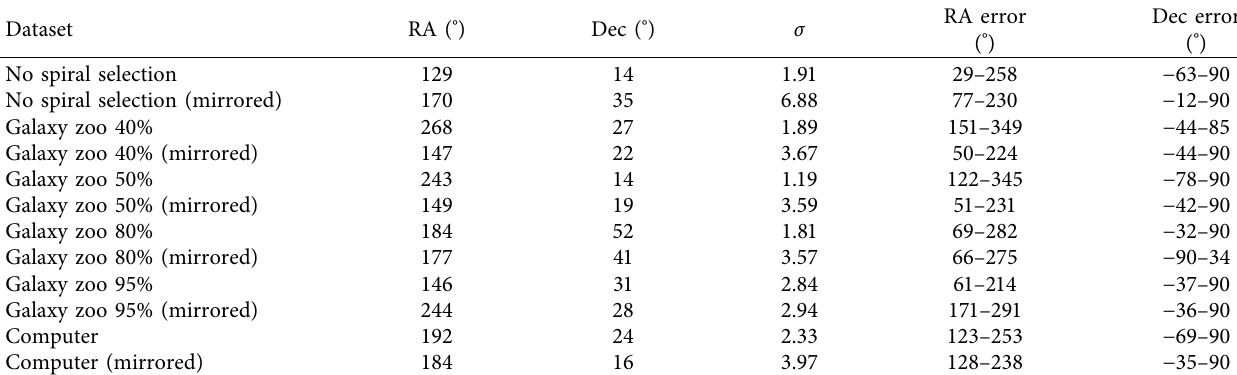
Table 3. It is also close to the location of the dipole axis observed with Pan-STARRS [4] at ( α � 197 o , δ � 2 o ) , and DECam [6] at ( α � 237 o , δ � 10 o ) .